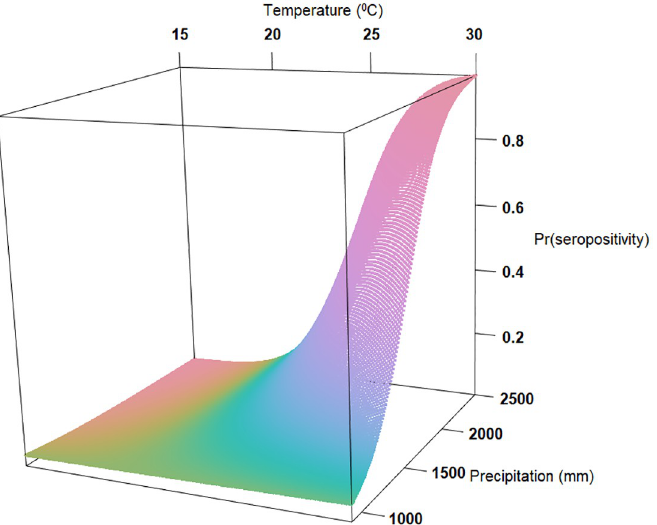
Fig 4. Three-dimensional graph shows the predicted probability of Leptospira serovar Hardjo seropositivity, Pr (seropositive), as a result of the interaction of increased temperature (˚C) and precipitation (mm), and accounting for all other fixed effects in final generalised linear mixed effects